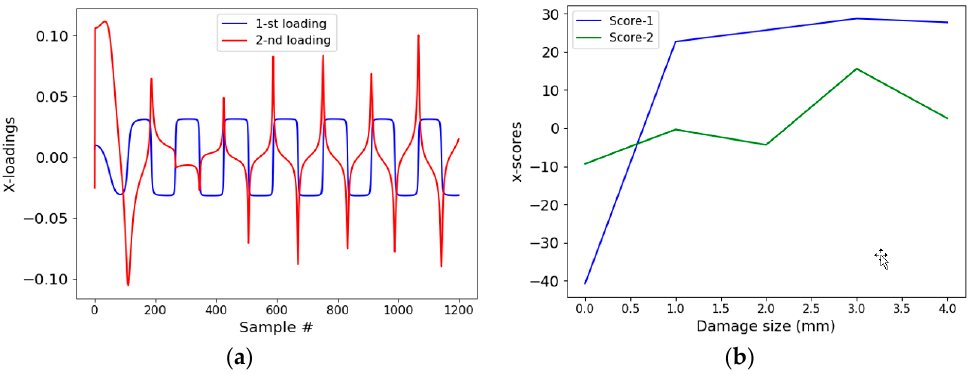
Figure 5. ( a ) 1st and 2nd X-loading vector estimated using partial least squared regression (PLSR); ( b ) 1st and 2nd X-score estimated after convoluting x-loading score and signal.